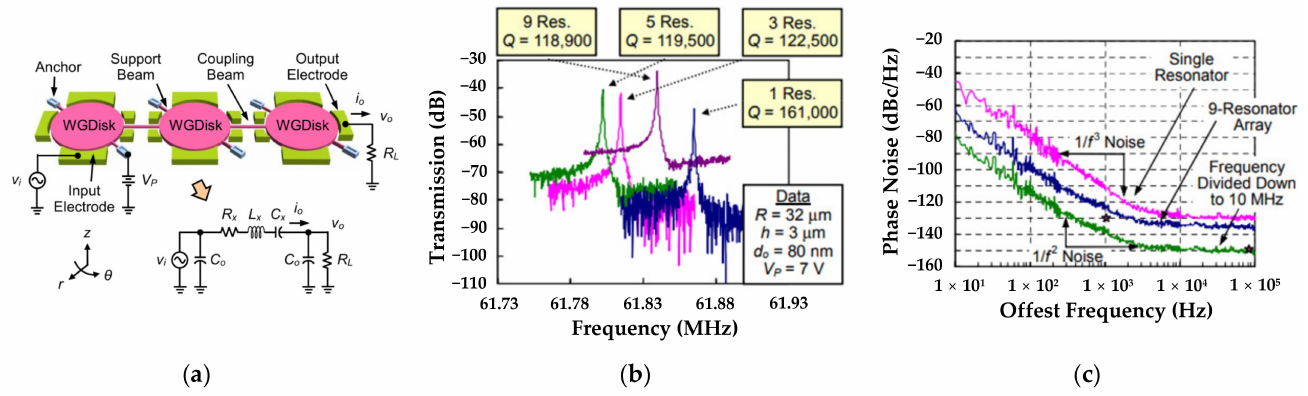
Figure 31. ( a ) Schematic of a 3-DoF strongly coupled disk resonator system with the equivalent electric circuit; ( b ) Measured frequency response for several multi-DoF disk resonator systems; ( c ) Relationship between the offset frequency and phase noise. Adapted with permission from Ref.